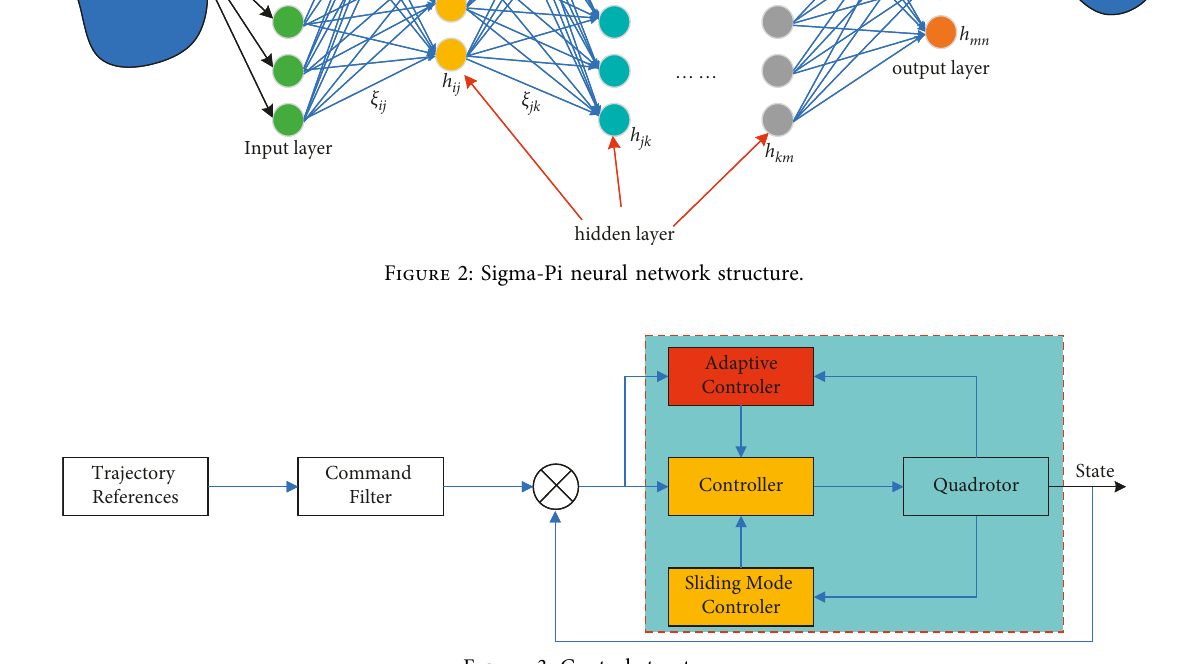
Figure 3: Control